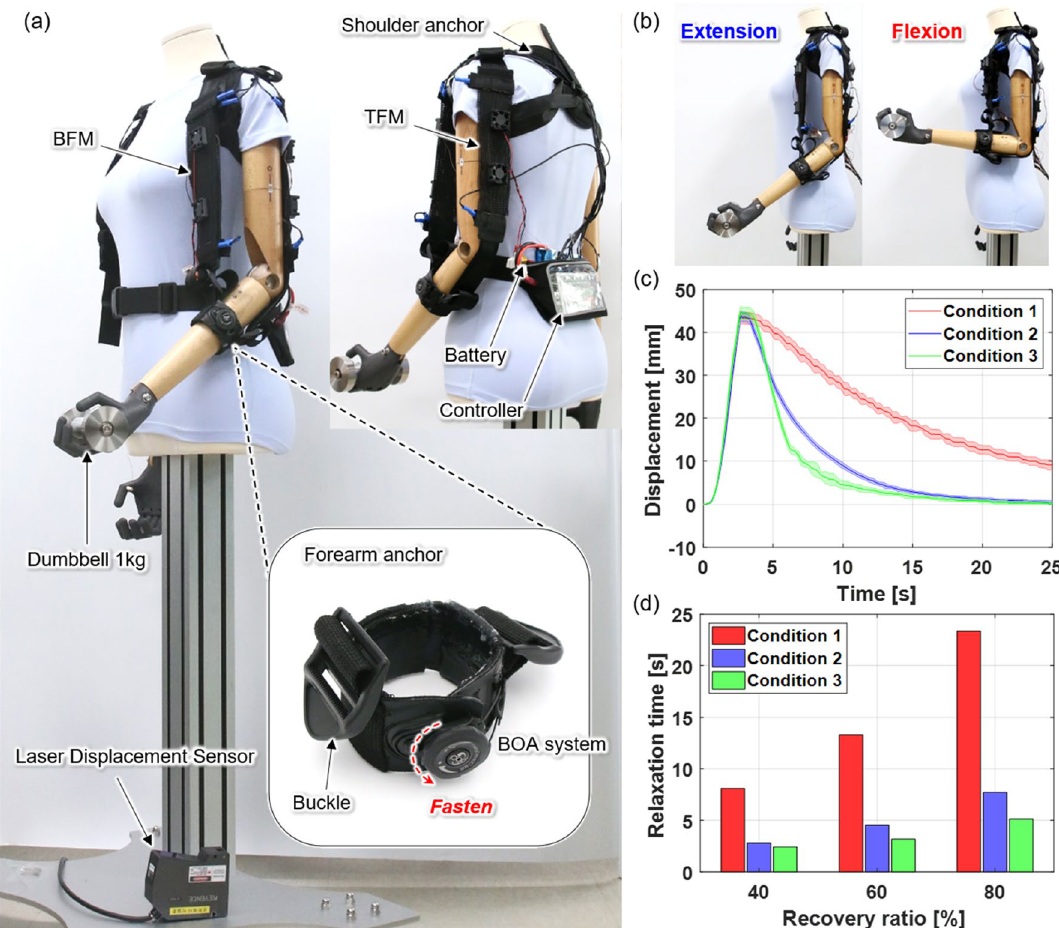
Figure 6. Assistance of the mannequin’s flexion–extension motions by the exosuit. ( a ) Experimental setup. The shoulder anchor was made with length-adjustable straps. The forearm anchor uses a BOA (BOA Technology Inc., Denver, USA) fastener to enable easy loosening and tightening. The upper ends of the BFM and TFM are connected to the shoulder anchor, and the lower ends are connected to the forearm anchor. A laser displacement sensor installed on the floor measured the contraction-relaxation displacement of the fabric muscle. A thermocouple inside the BFM and TFM to measure the temperature. ( b ) The mannequin arm lifts a 1-kg dumbbell with the assistance of the exosuit. When the BFM relaxes and the TFM contracts, the mannequin arm is in an extended state (left), and when the BFM contracts and the TFM relaxes, the arm becomes is in a flexed state (right). ( c ) Comparison of flexion and extension responses under three different conditions (see Video S2). ( d ) Relaxation times for the three different recovery ratios of By mounting the exosuit on a mannequin that does not have its own force to lift or lower a load, the exosuit’s assistive force effect can be evaluated. A 1 kg dumbbell was attached to the hand of the exosuit-wearing man- nequin. The BFM and TFM of the exosuit were arranged antagonistically. Therefore, the more the stiffness was reduced by lowering the temperature of the fabric muscle opposite the actuating fabric muscle, the greater force was exerted on the arm by the actTuating fabric muscle while minimizing loss. The flexion–extension motion assistance performance of the exosuit (Fig. 6b) was evaluated under the following three conditions: (1) biceps- only + NCC. (2) Biceps-only + fan cooling. (3) Biceps and triceps + fan cooling.